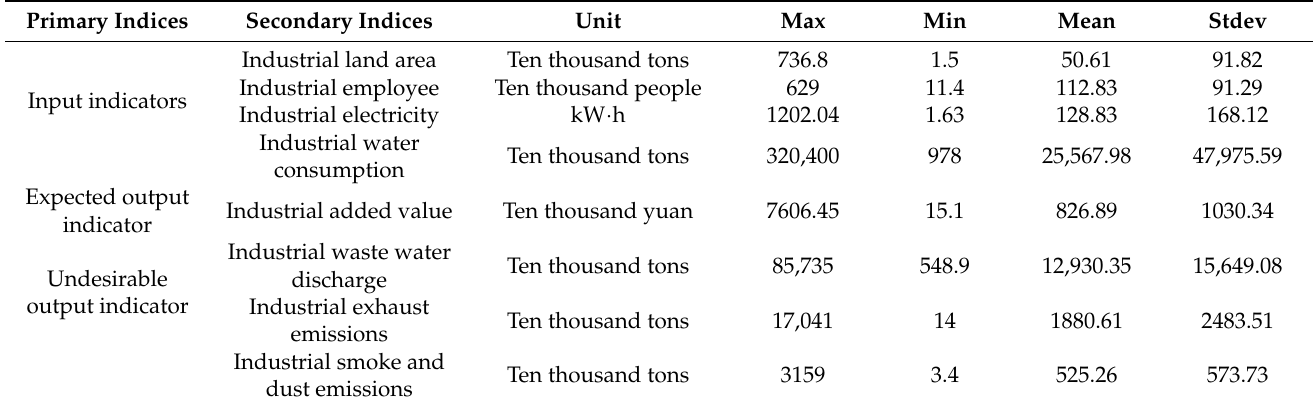
Table 1. The evaluation indicators of industrial eco-efficiency